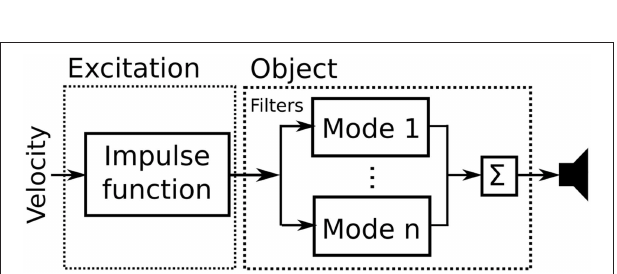
FIGURE 2 | Block diagram of the modal synthesis